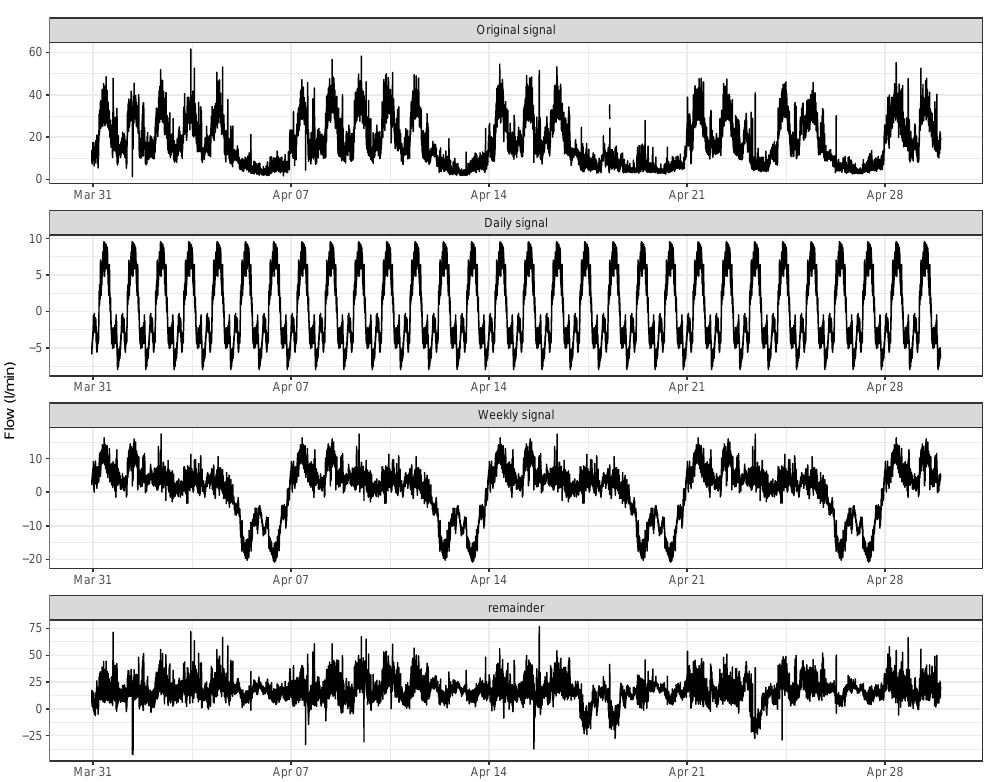
Figure 3. One-month STL(seasonal trend decomposition based on Locally Estimated Scatterplot Smoothing (LOESS)) decomposition. The different plots show, from top to bottom, the original signal (raw data), the seasonal (both daily and weekly), and the remainder